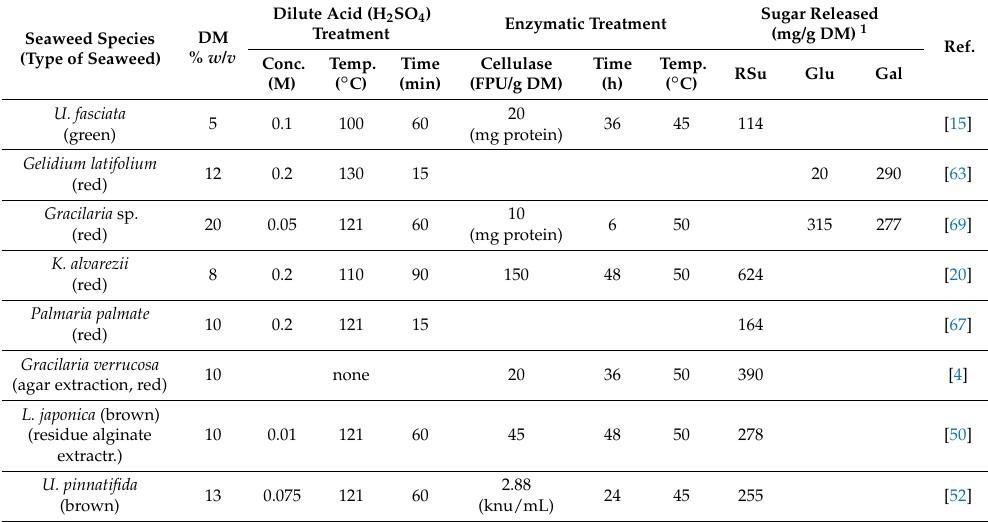
Table 4. Summary of dilute acid and enzymatic hydrolysis conditions and their sugar yield. Seaweed Species (Type of